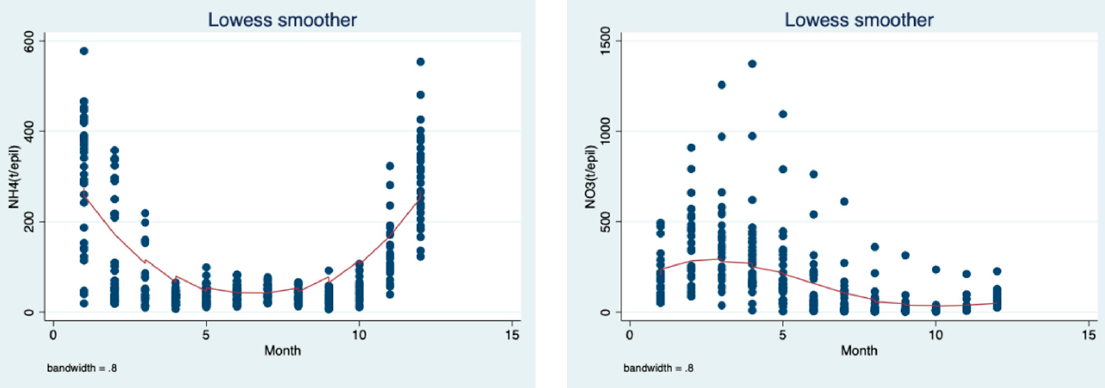
8 of 14 Figure 9. Linear prediction (95% CI) ( left ) and LOWESS smoother (0.8 bandwidth) trend of changes ( right ) between annual means of nitrate loads (ton) in River Jordan waters (Huri Station) and River Jordan discharge (mcm; 10 6 m 3 per year) during 1968–2018. The results given in Figure 10 indicate a significant temporal elevation in the mass (ton) ratio between nitrate and ammonium loads in the water of the River Jordan from 1968 to 2018. Figure 10. Linear prediction (95% CI) ( left ) and LOWESS smoother (0.8 bandwidth) trend of changes ( right ) between annual means of mass (ton) ratio and between nitrate and ammonium in River Jor- dan water (Huri Station) and years (1968–2018). The data evaluation in Figures 11 and 12 are the long-term (1970–2018) monthly means of nitrate and ammonium loads (ton) (Figure 11) and the Peridinium wet biomass and total nitrogen (Figure 12) in the epilimnion of Lake Kinneret evaluated as a LOWESS